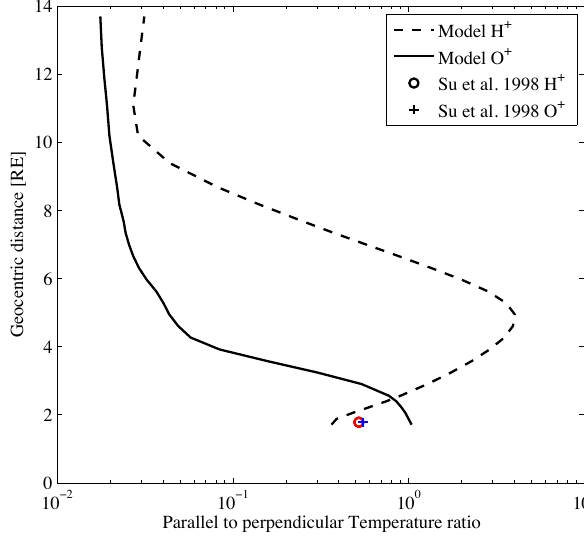
Fig. 8. Altitude profiles of ions temperature anisotropy (T k (cid:14) T ⊥ ) , for O + ions (solid line) and H + ions (dashed line), when perpen- dicular wavelength of the electromagnetic turbulence λ ⊥ = 8km. Different corresponding observations are marked on the